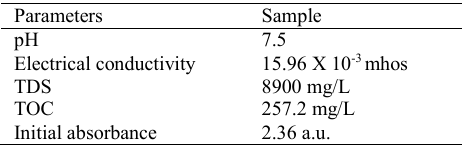
Table 1. Various parameters of industrial effluent samples